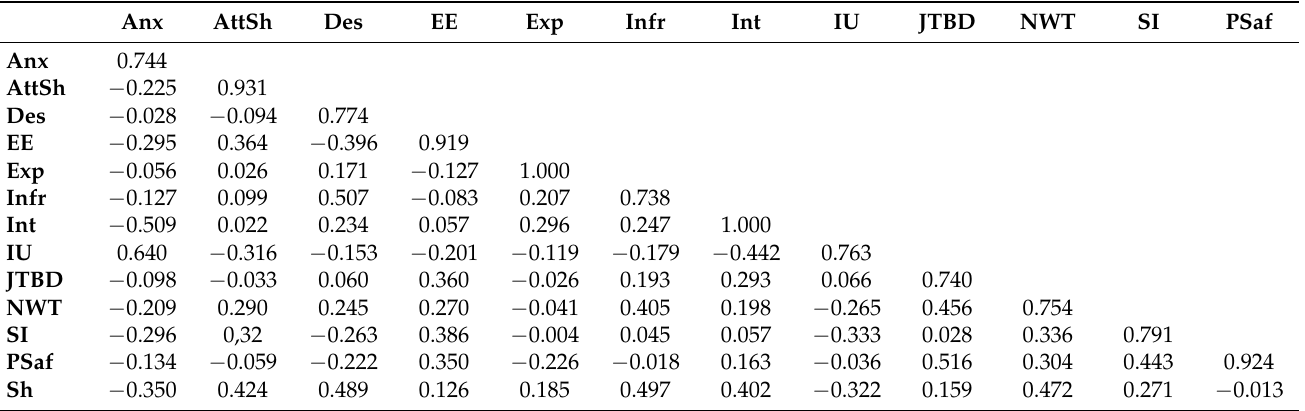
Table A3. Discriminant validity, Fornell–Larcker